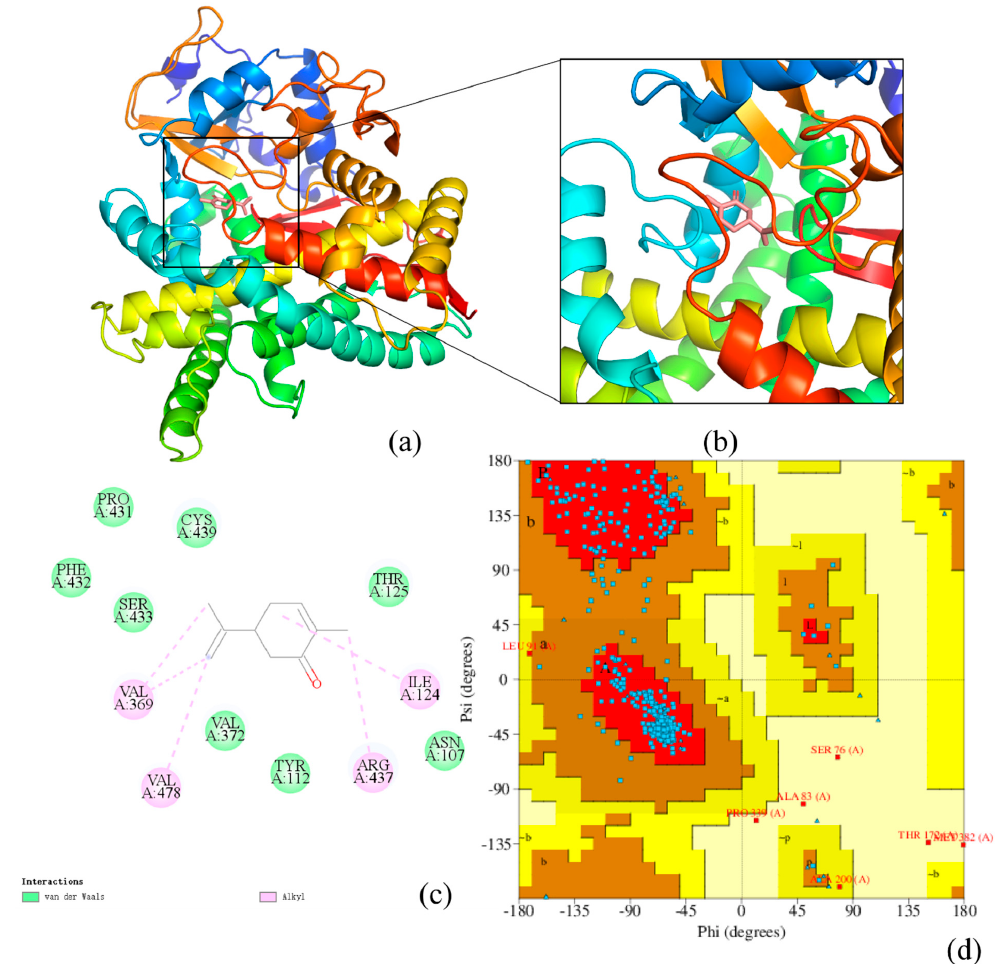
Figure 4. Tertiary structure prediction of Bx-cyp29A3 . ( a ) The tertiary structural homology model of Bx-cyp29A3 . ( b , c ) Molecular docking of Bx-cyp29A3 with L( − )-carvone. The green ball represents the van der Waals forces. The pink balls represent the existence of an alkyl interaction. The pink dotted line is the σ bond formed by the alkyl force; ( d ) Ramachandran plot of Bx-cyp29A3 . a: Core alpha; b: Core beta; L: Core left-handed alpha.